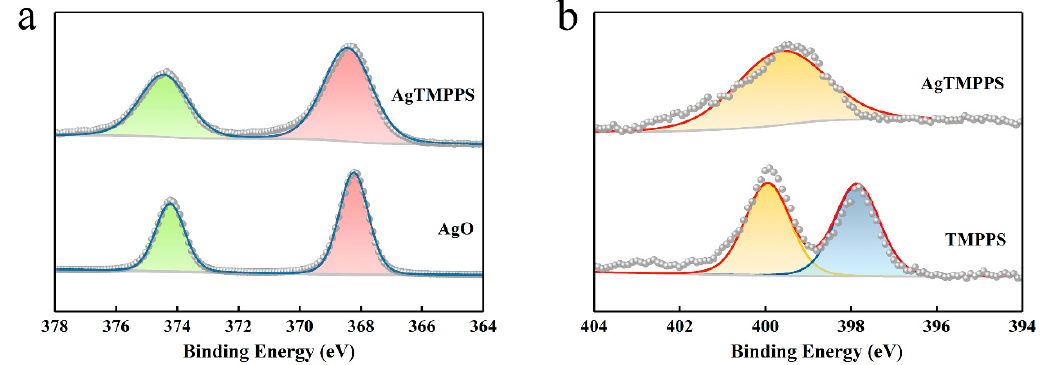
Figure 3. XPS narrow-scan spectra. ( a ) Ag 3d spectra of AgO and AgTMPPS. ( b ) N 1s spectra of TMPPS and AgTMPPS.